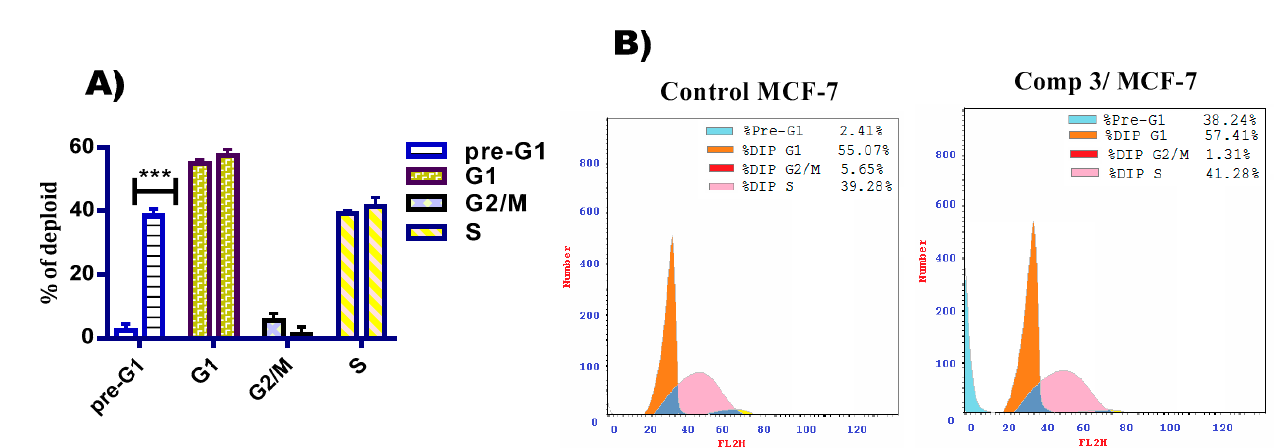
Figure 4. ( A ) Graphical representation of percentages of cells in pre-G1, G1, G2/M, and S cell cycle phase in MCF-7 cells treated with compound 3 (2.89 µM) for 48 h. ( B ) Effect of compound 3 (2.89 µM) on cell cycle distribution in MCF-7 cells for 48 h and analyzed by flow cytometry after staining with DNA fluorochrome propidium iodide; most of the compound 3 treated cells were in pre-G1 phase (apoptosis). Data are expressed as the mean ± SD ( n = 3 experiments) and statistical comparisons were carried out using one-way analysis of variance (ANOVA) followed by Tukey’s multiple comparison test (*** p < 0.001). ***-Highly significant.